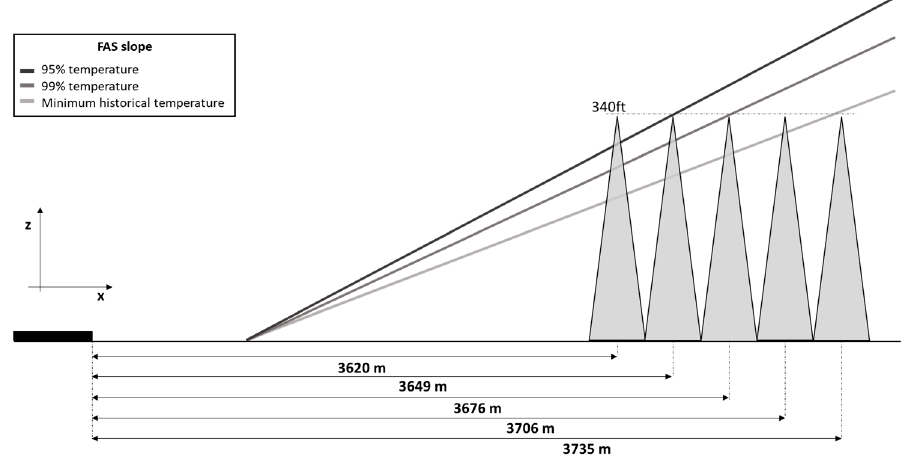
Figure 13. FAS slope with the same obstacle (same height) in di ff erent positions.